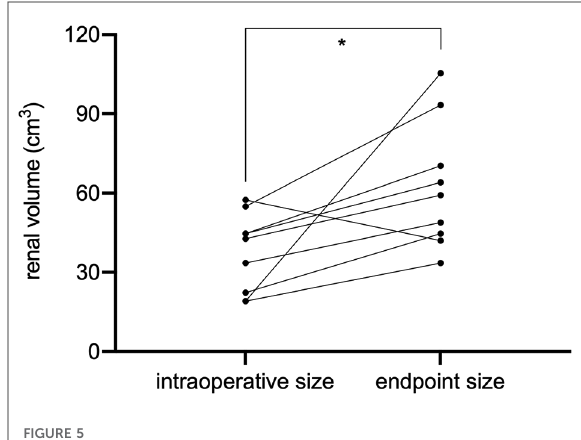
FIGURE 5 Renal volume at surgery and follow-up endpoint (* P